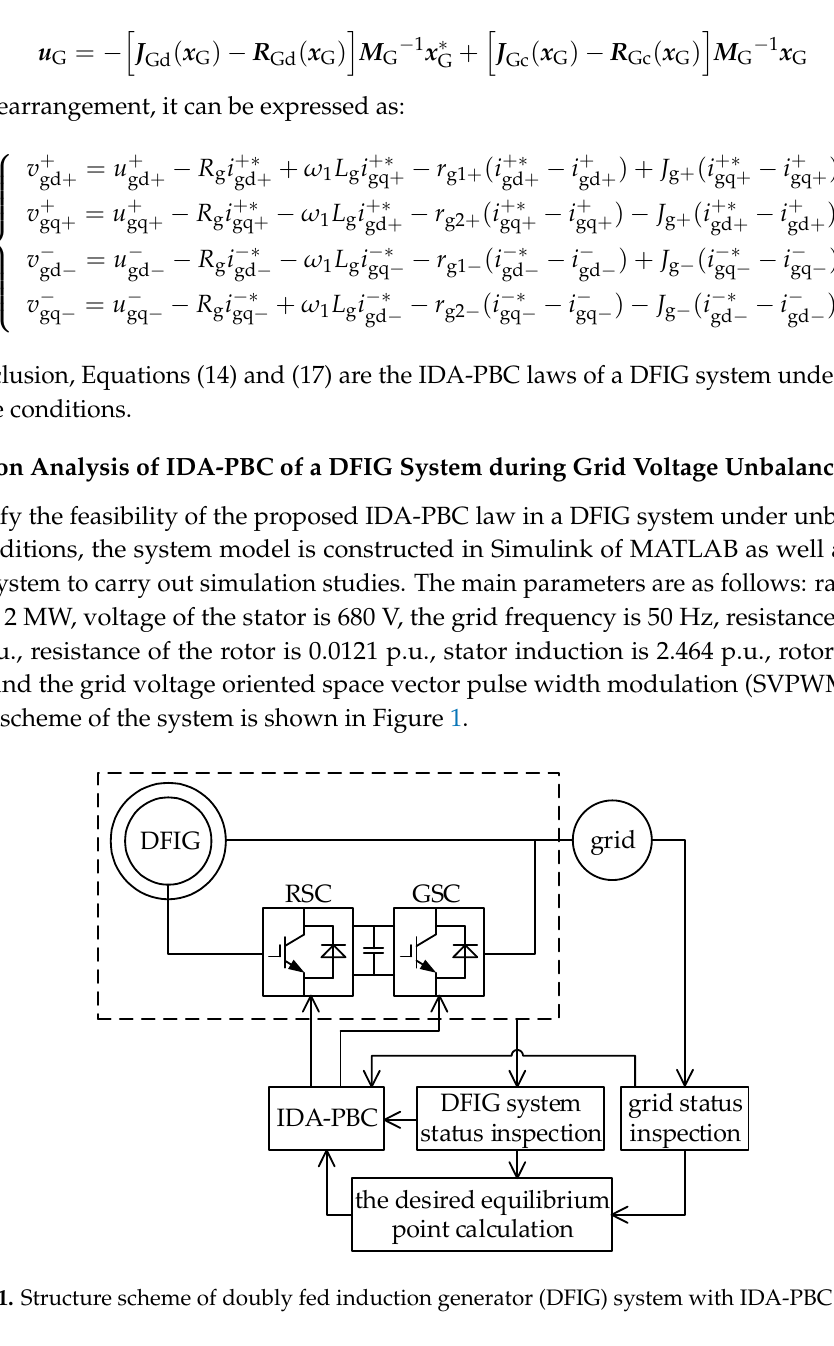
and the desired equilibrium point.